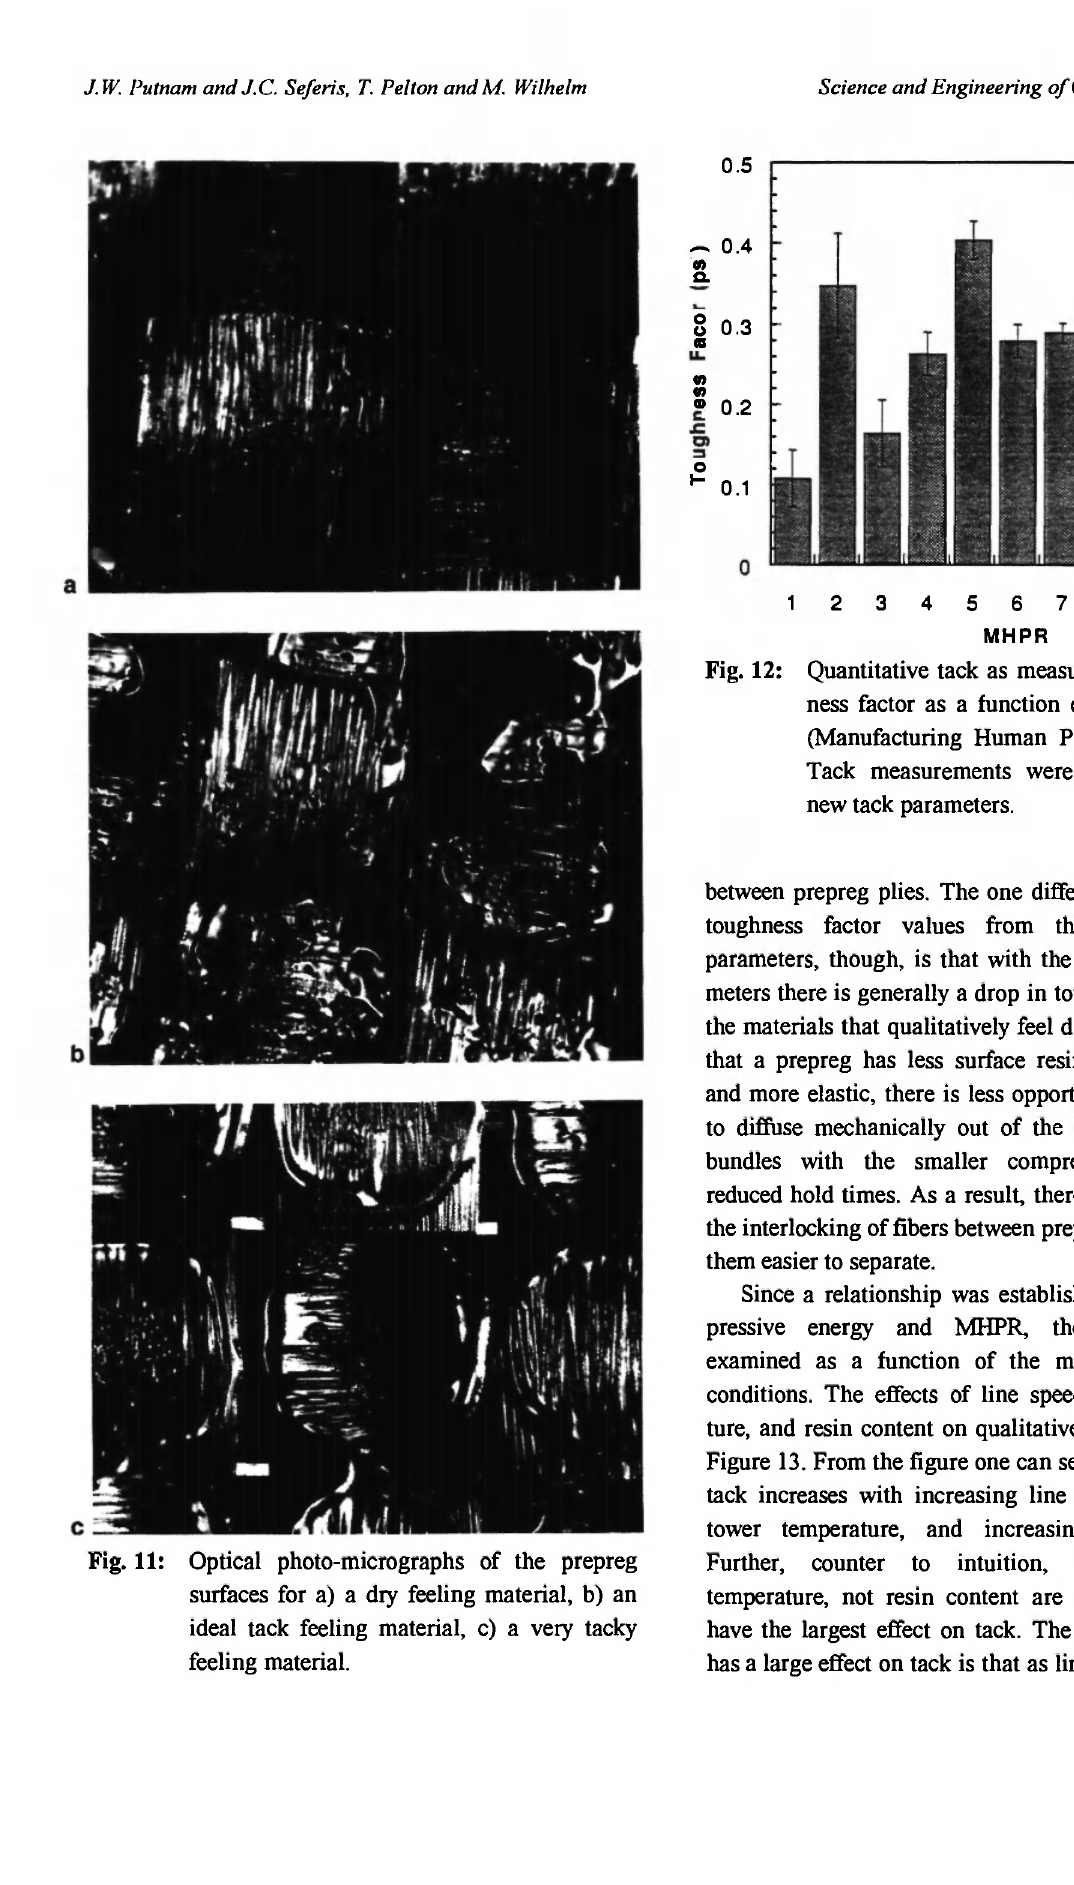
Fig. 12: Quantitative tack as measured by the tough- ness factor as a function of qualitative tack (Manufacturing Human Perceptive